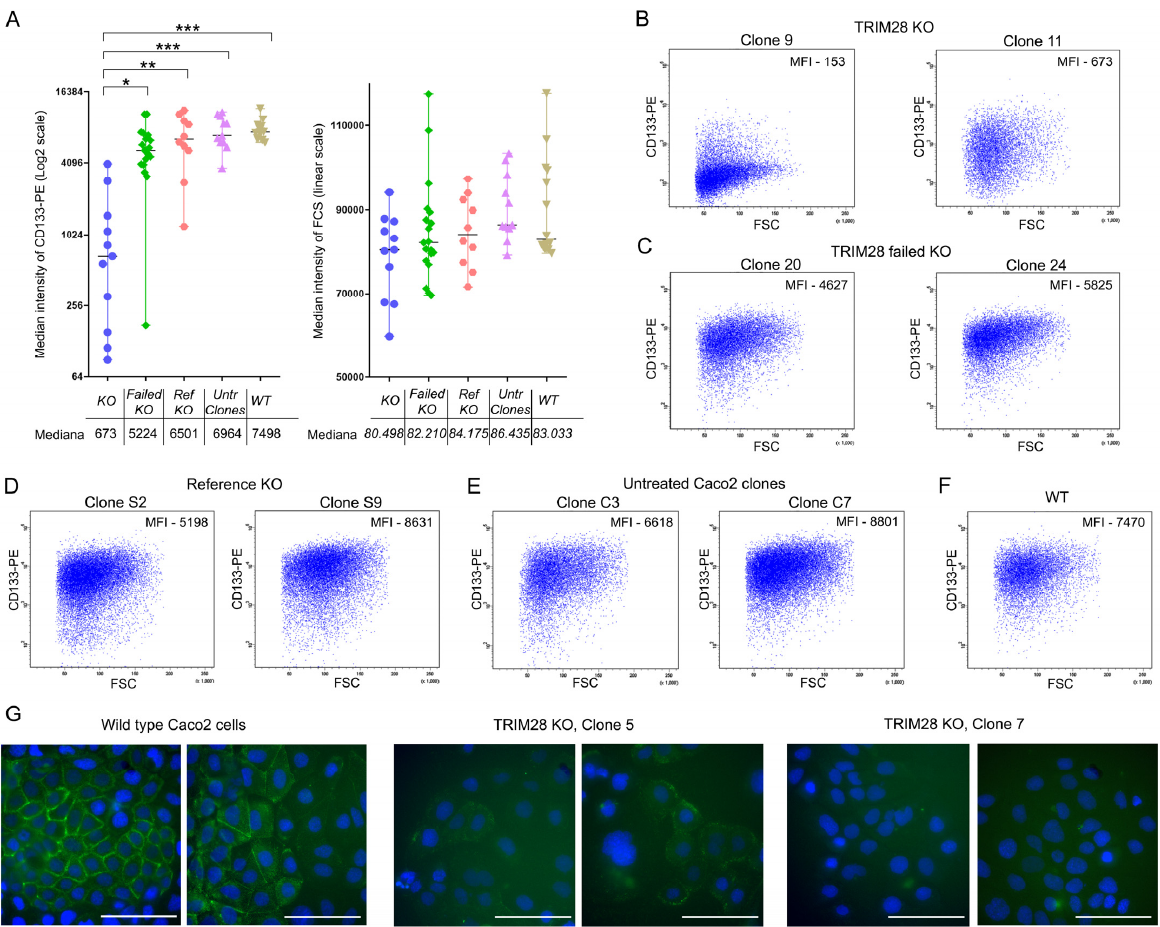
Figure 4. Downregulation of CD133 by full depletion of TRIM28 in Caco2 clones. ( A ) Left graph: CD133-PE median fluorescence intensity (MFI) of cells in full TRIM28 knockout and negative control groups (Log2 scale). Right graph: forward scatters (FSC) of cells in full TRIM28 knockout and negative control groups (linear scale). «KO» —clones with full knockout of TRIM28 ( n = 11, blue circles); «Failed KO»—clones with attempted but failed TRIM28 knockout ( n = 19, green diamonds); «Ref KO»—clones with attempted knockout using gRNA targeted to tagRFP non-mammalian gene ( n = 10, pink hexagons); «Untr Clones»—«untreated» clones generated without the knockout proce- dure ( n = 11, violet triangles); «WT»—wild-type cells analyzed in 14 independent experiments (yel- low triangles). ( B – F ) Representative FACS plots of CD133 expression in analyzed groups. ( G ) CD133 immunocytochemical staining (green color) in live Caco2 cells with or without TRIM28 knockout. Scale bar—100 µm. * p ≤ 0.05; ** p ≤ 0.01; *** p ≤ 0.001.